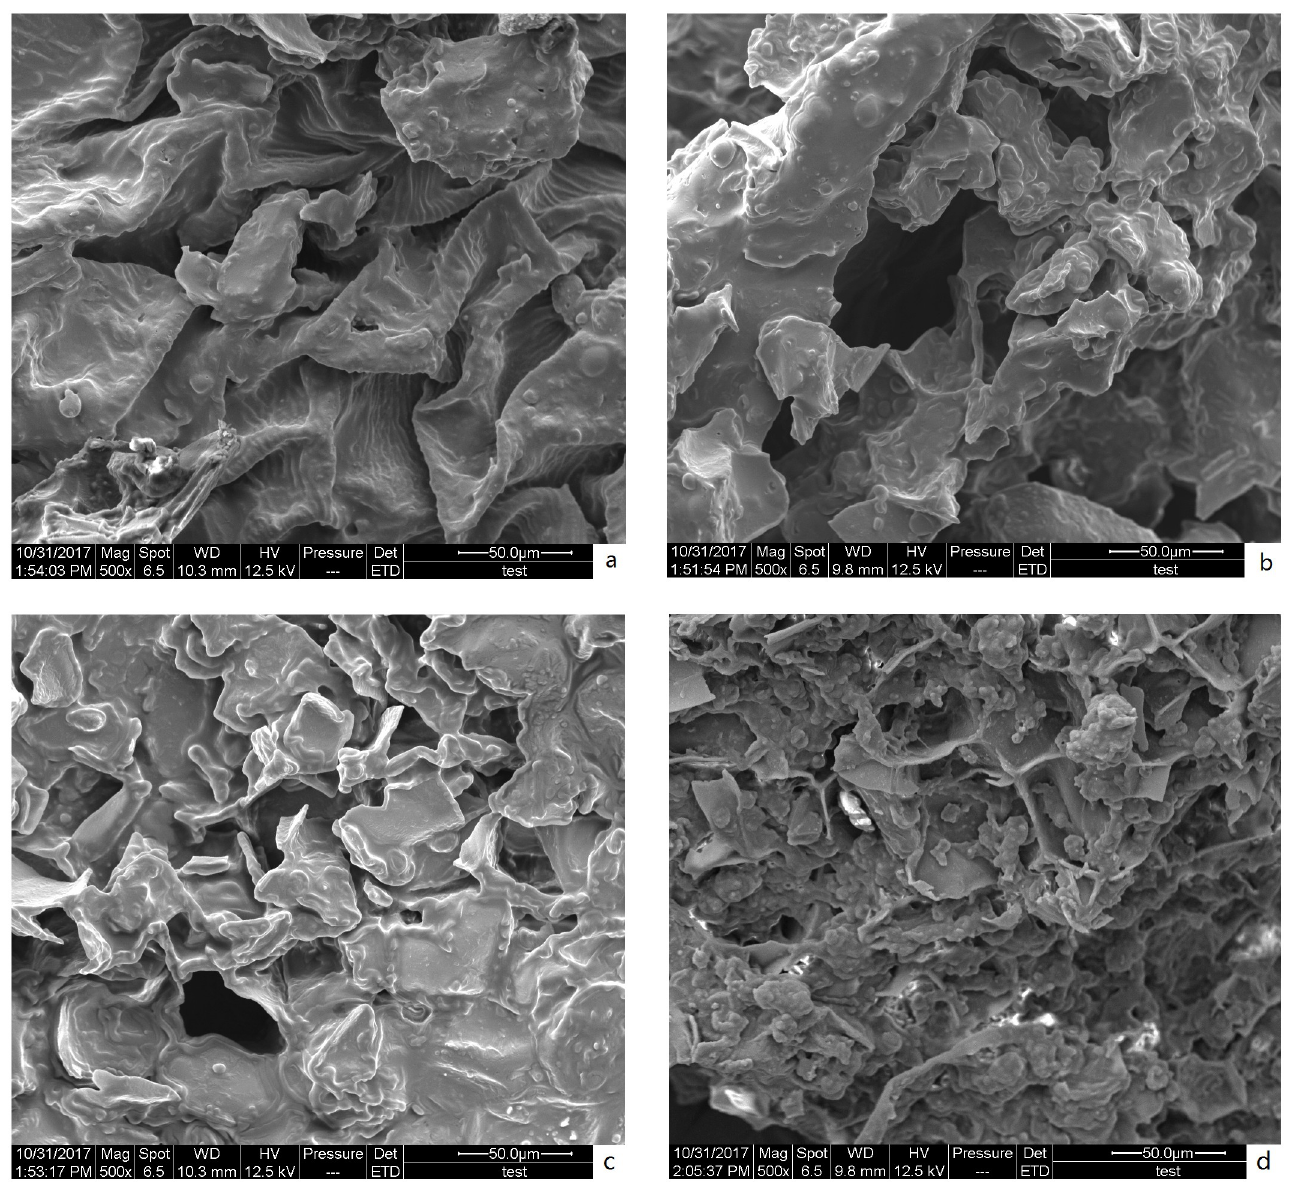
Fig 6. SEM images of S . chinensis fruit raw materials (a) and S . chinensis fruit residue after treatment by refluxing in IL (b), MAH in ethanol (c), and MAH in IL solution (d).